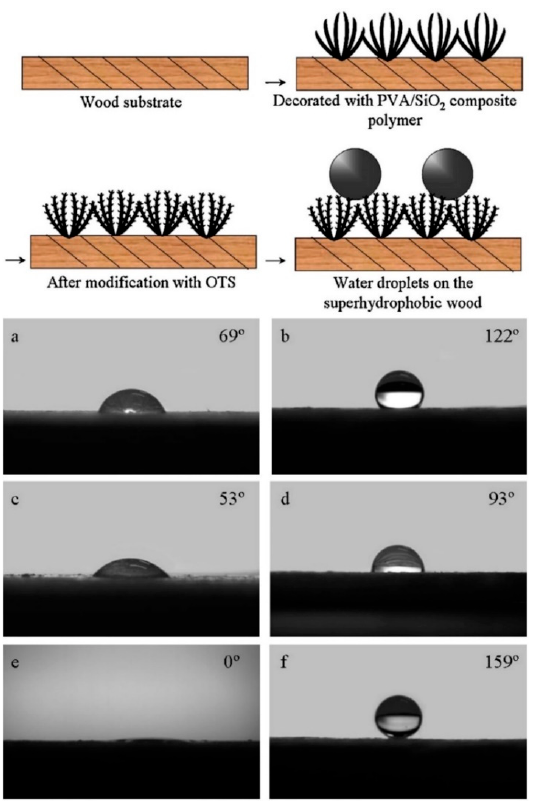
Figure 6. A schematic diagram of the forming process for superhydrophobic wood and images of water droplets on different surfaces: ( a ) the pristine poplar wood surface; ( b ) the wood surface modified by OTS reagent; ( c ) the wood surface covered with pure PVA; ( d ) the wood surface coated with pure PVA then modified by OTS reagent; ( e ) the wood surface coated with the PVA/SiO 2 composite polymer; ( f ) the wood surface coated with the PVA/SiO 2 composite polymer then followed by OTS modification. Reprinted with permission from [74] 2013